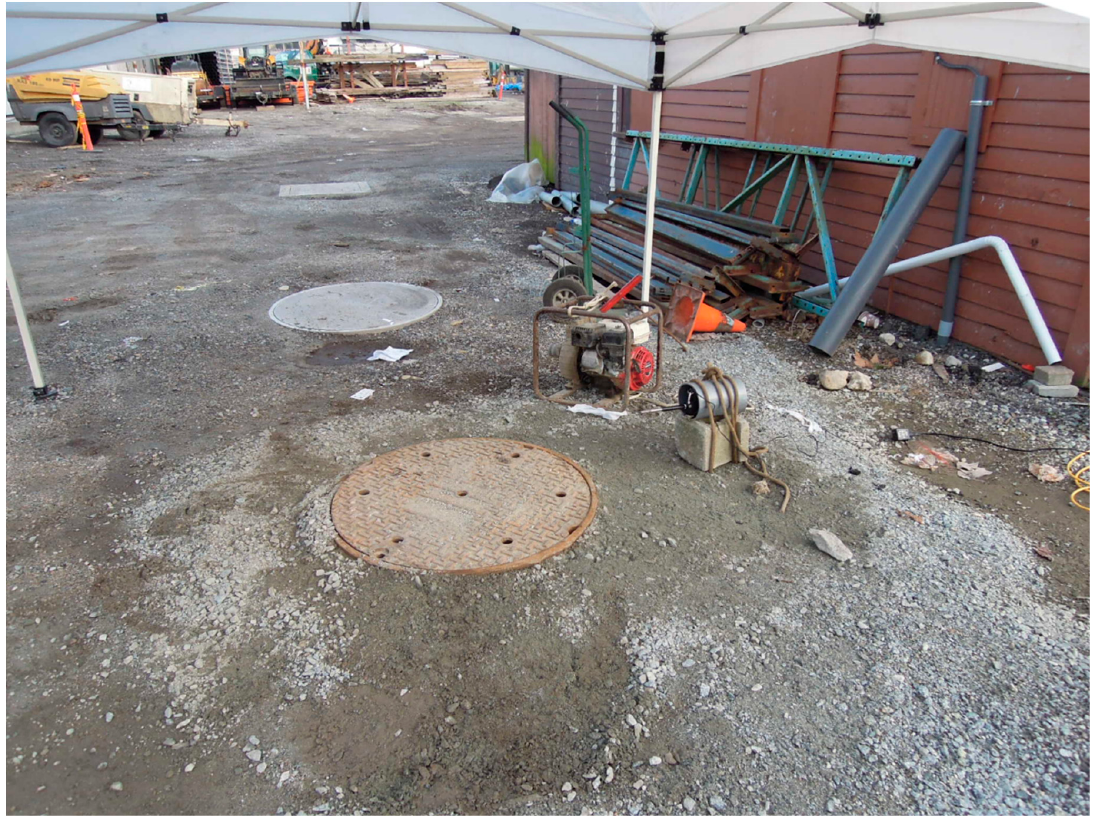
Figure 1. Study area. Manhole covers on top of the isolated subsurface structure were located along the north wall of a house. The canopy shelter minimized exposure to the sun and rain and protected instruments used during the study.